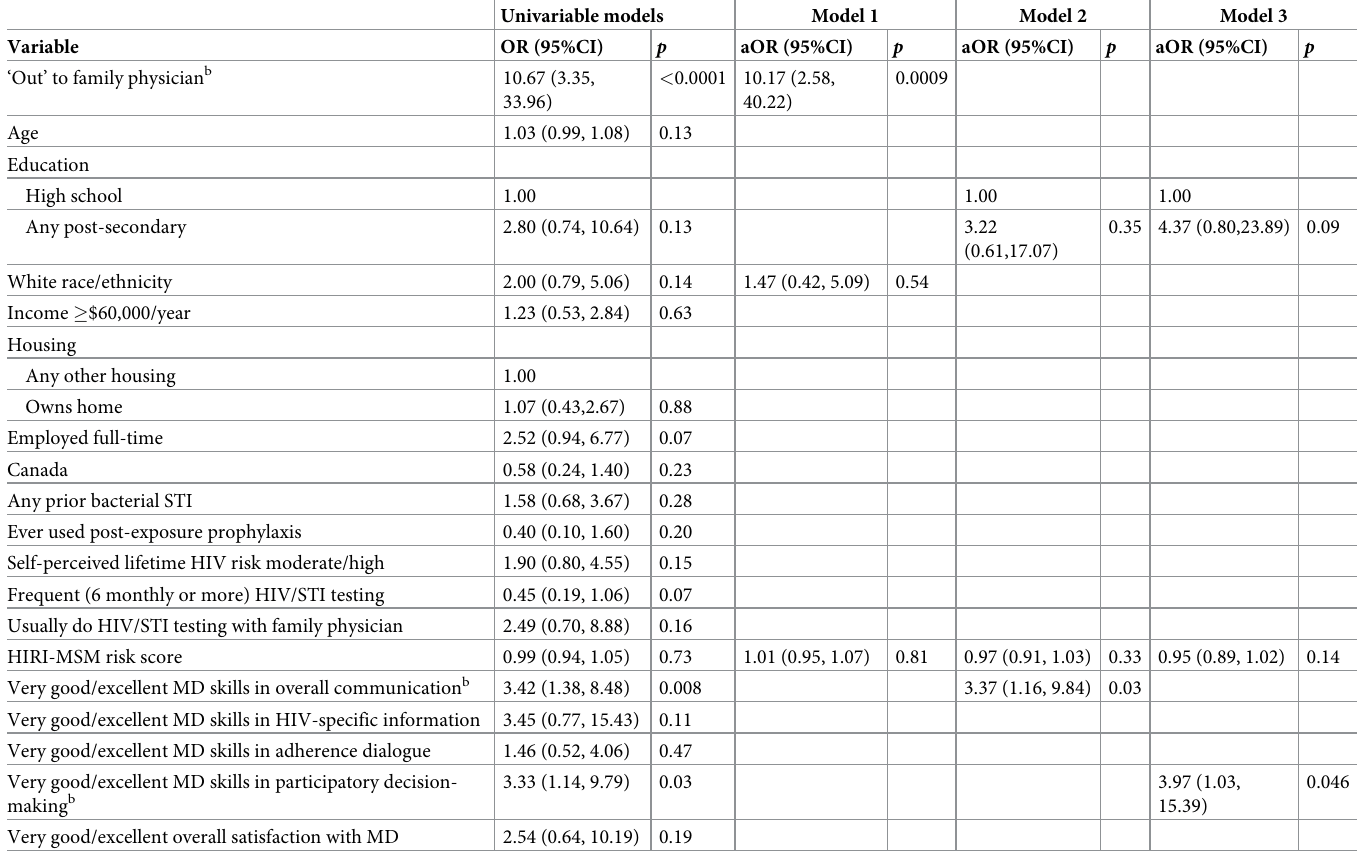
Table 2. Variables associated with intent to seek PrEP from family physicians a